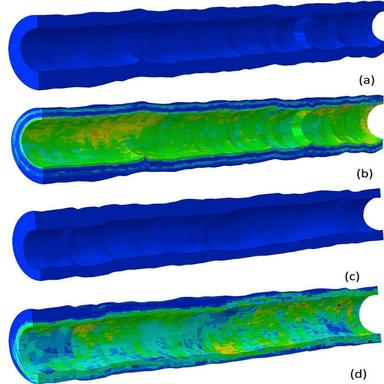
Finite element model generated by python scripts for case 3 in the unloaded and loaded configuration (a and b) and case 8 in the loaded and unloaded configuration (c and d). Von Mises stress is shown to highlight the effects of heterogeneous mechanical properties on stress distribution.